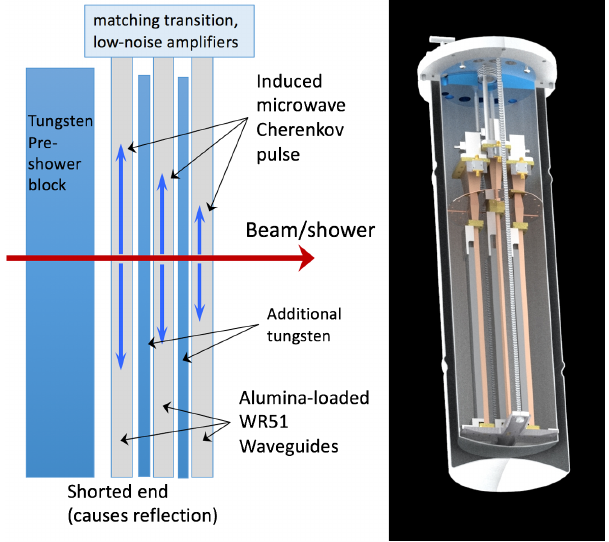
FIG. 1. Left: Block diagram of basic geometry of the detector. Right: Rendering of the detector elements inside of the liquid nitrogen